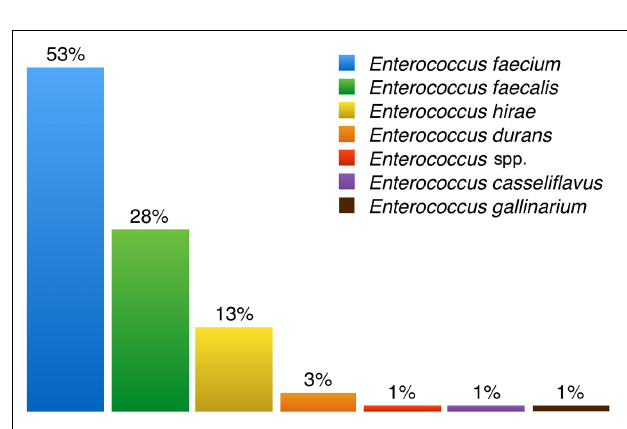
FIGURE 5 | Percentages of enterococci species isolated from samples. Enterococcus faecium is the most frequently isolated enterococci species among all recovered samples and Enterococcus gallinarum the